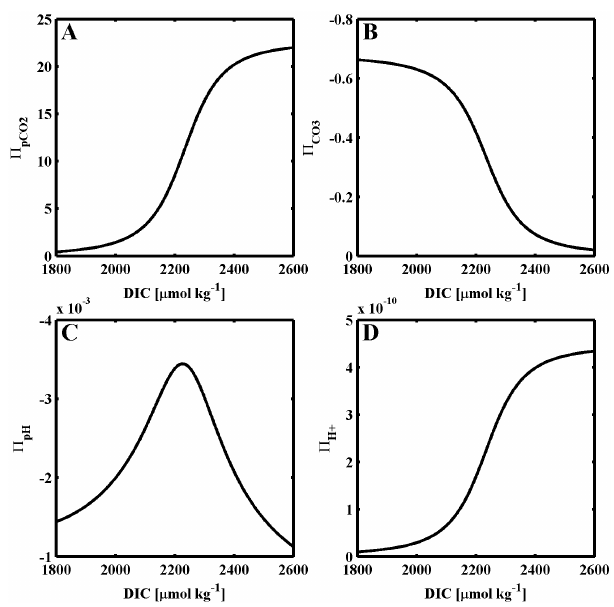
Figure 13. Buffer factor (cid:53) for p CO 2 (a) , CO 2 − [H + ] (d) as a function of DIC. Note the inverted y axis in pan- els (b) and (c) . Model parameters to calculate the (cid:53) values were TA = 2240µmolkg − 1 , temperature = 10 ◦ C, salinity = 33.5, pres- sure = 1.013 bar.